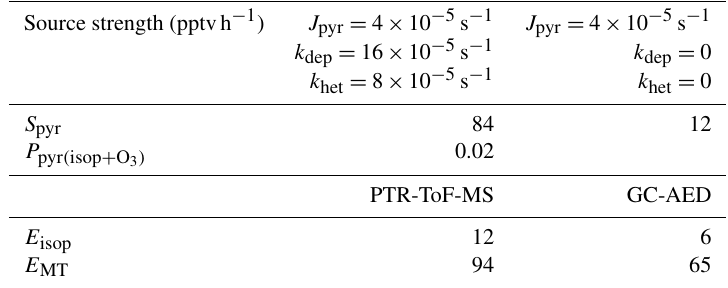
), and emission rates of isoprene 3 )